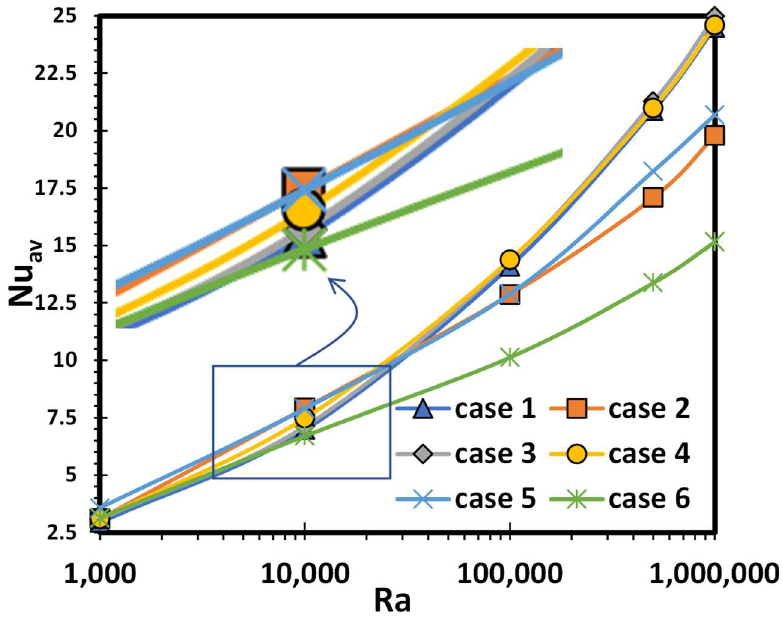
Figure 12. Average Nusselt number at the heat source for different Ra and heat source positions.